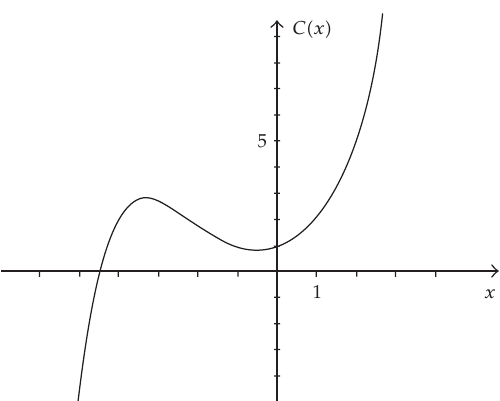
Figure 4: Graph of the Cantor function C for real